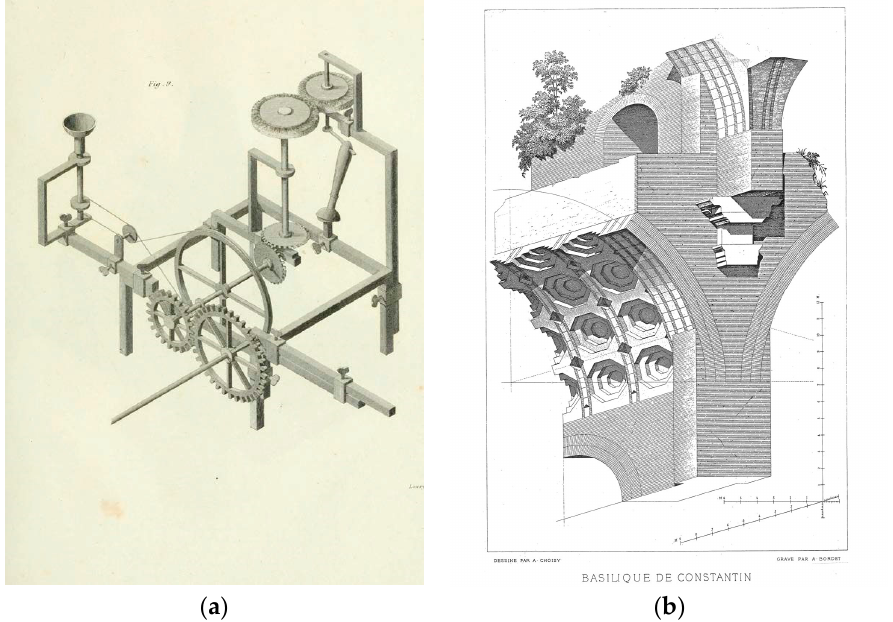
Figure 7. ( a ) William Farish, Optimal-grinding engine model, 1822; ( b ) Auguste Choisy, Planche III— Basilique de Constantin, from “L’Art de Bâtir chez le Romains”,